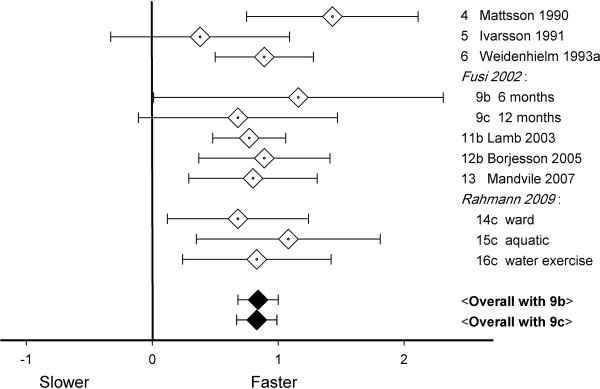
Walking speed effect-sizes 6–12 months after knee arthroplasty; bottom lines: overall effect-sizes, 95% CI 0.68–1.00 (with 9b), or 0.67–0.99 (with 9c).